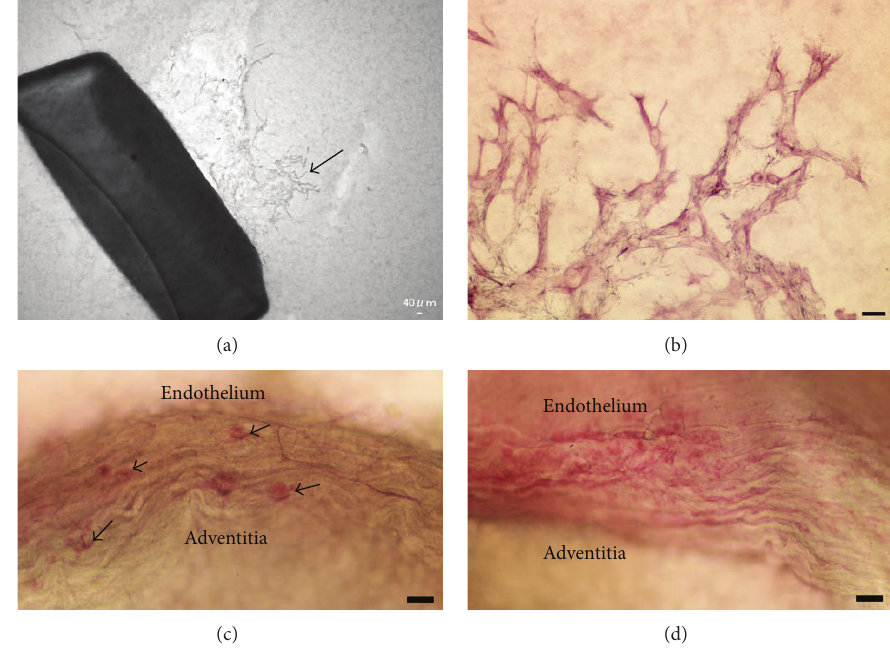
Figure 5: Immunohistochemistry of CD133. (a) In the early stages of culture (4-day culture), CD133-positive cells (arrow) were detected among cells migrating from the rat aortic explant. (b) Enlarged image of migrating CD133-positive cells. Scale bar = 20 𝜇 m. (c) CD133 expression (arrows) was found in the smooth muscle layer and near the adventitia. Scale bar = 20 𝜇 m. (d) CD133 expression was also found in the endothelium and the smooth muscle layer. Scale bar = 20 𝜇